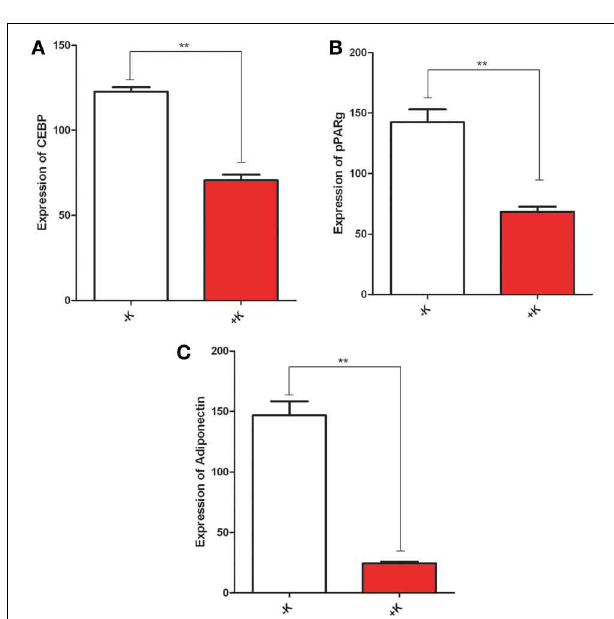
FIGURE 5 | Treatment of preadipocytes with K873, an analog of AA. 3T3 L1 were incubated without or with AA during 9 days in an adipogenic medium. RNAs have been extracted and expression of CEBP β (A) , PPAR γ (B) , and adiponectin (C) was evaluated. ∗∗ p < 0 .